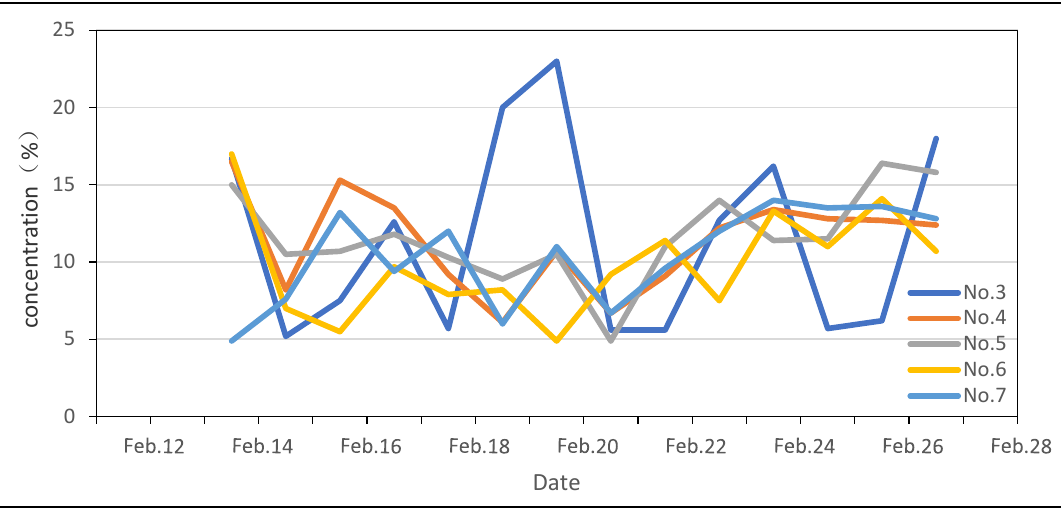
Figure 13. Gas concentration curve of some boreholes in No. 8 drilling field of Lane